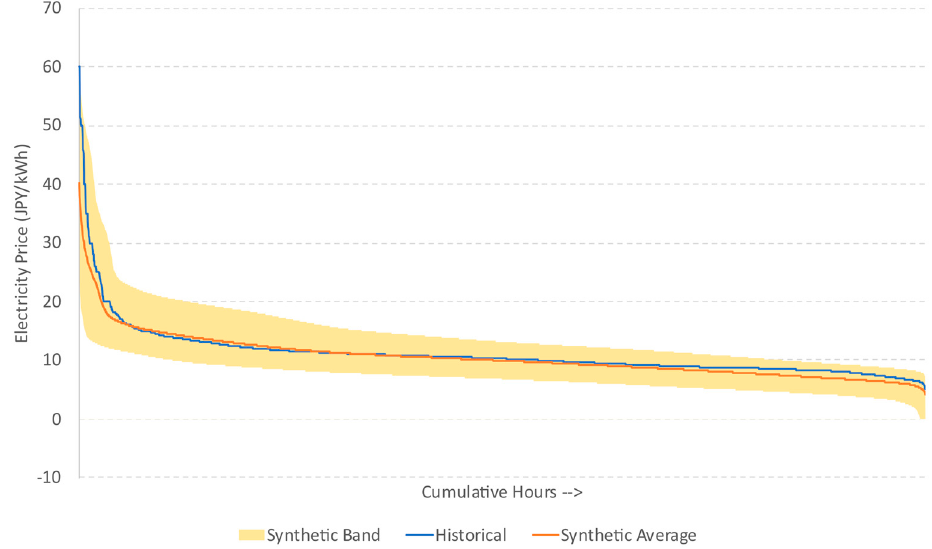
Figure 5. PDC comparison between the synthetic and historical data.